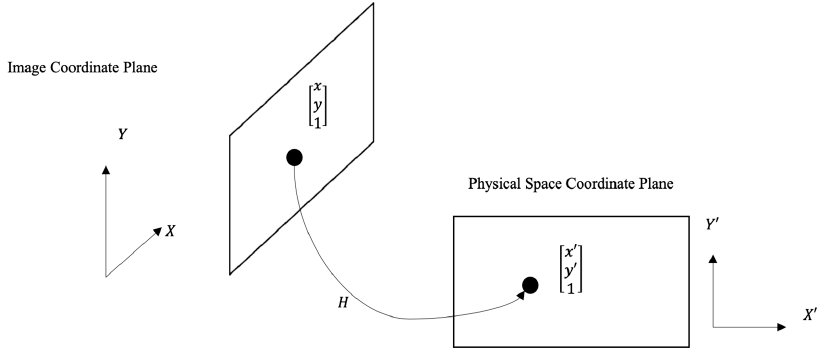
Figure 3. Spatial mapping from the image coordinate plane to the physical space coordinate plane.